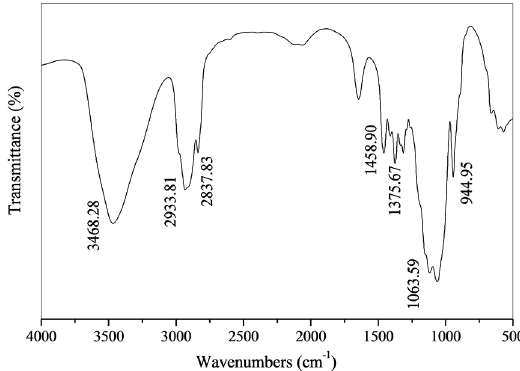
Figure 6: The FTIR-ATR spectra of pure methylcellulose.